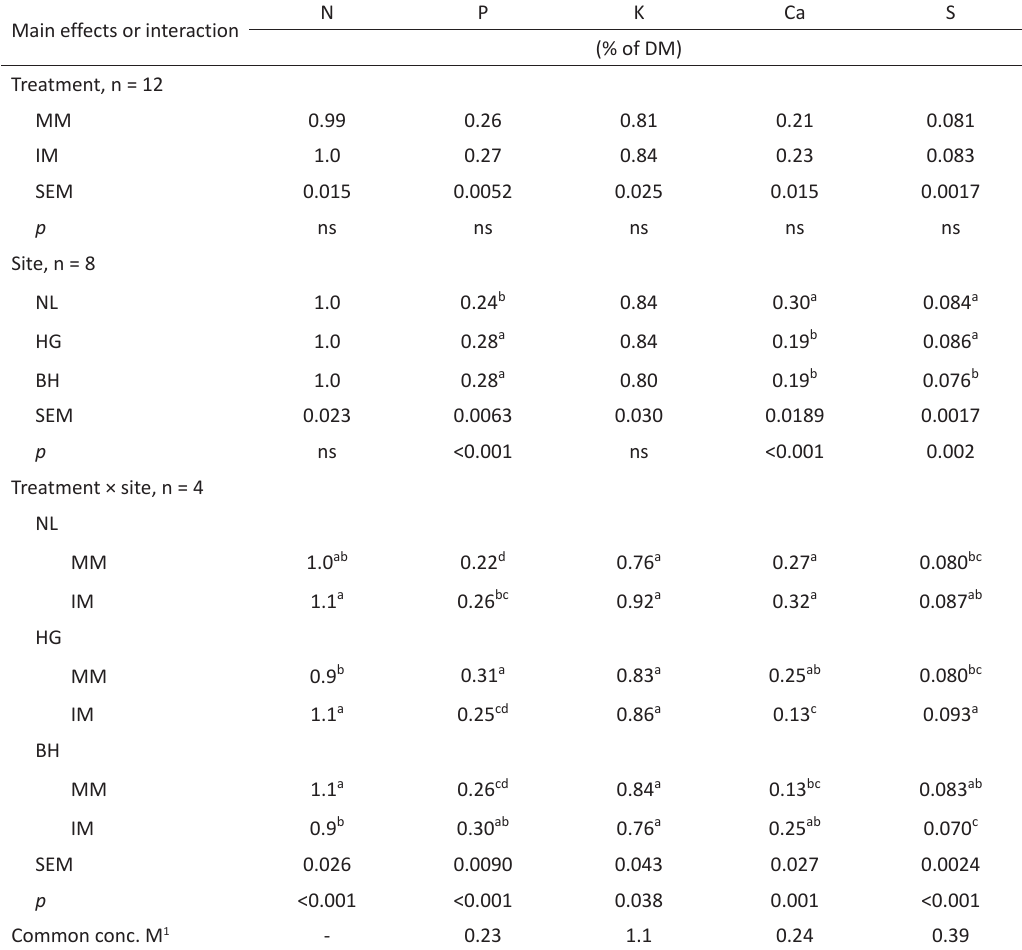
Table 4. Concentrations of macro nutrients in intercropped and monocropped maize in three field experiments Main effects or interaction